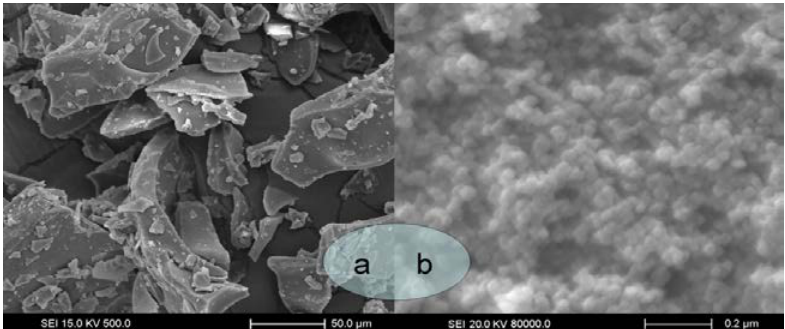
Figure 2. SEM images of unprocessed GTW ( a ), processed GTW was obtained under the optimum extraction condition: 29.4 MPa precipitation pressure, 63.5 °C precipitation temperature, 10.2 mg/mL drug concentration, 5.4 mL/min drug solution flow rate ( b